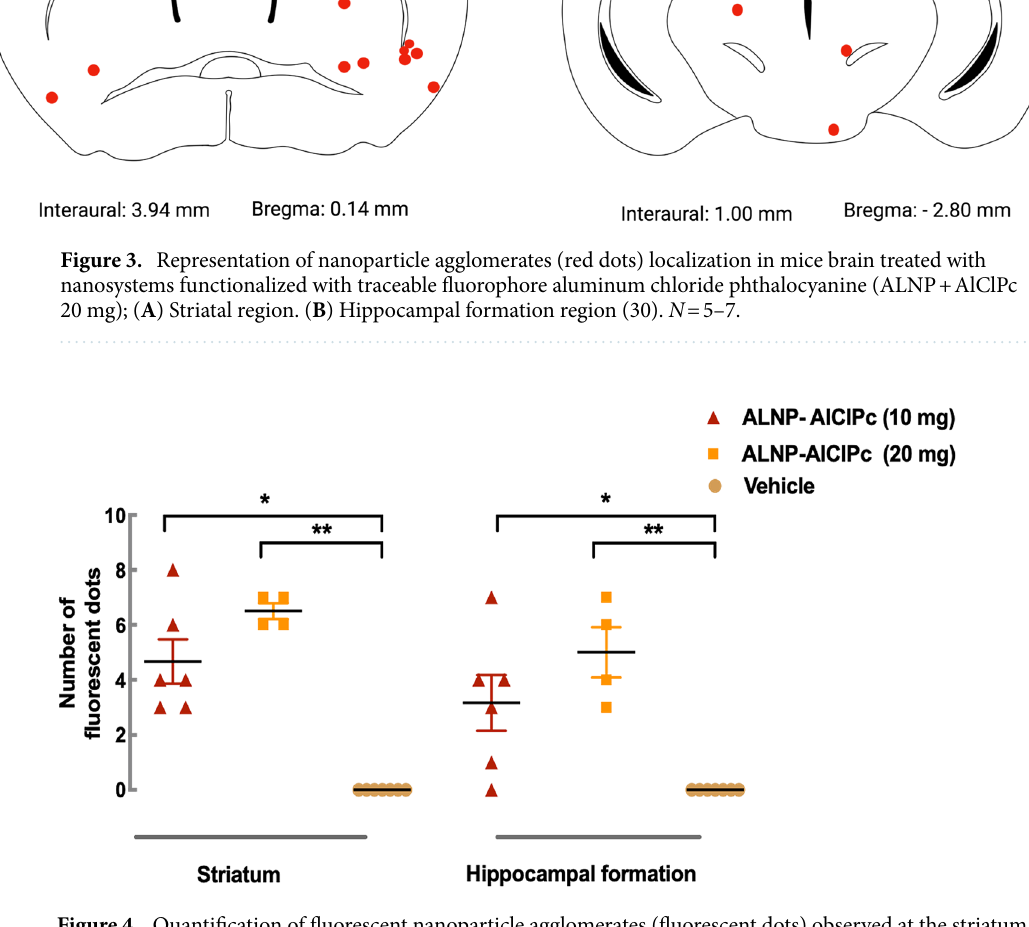
Figure 4. Quantification of fluorescent nanoparticle agglomerates (fluorescent dots) observed at the striatum or hippocampal formation according to treatment groups (saline vehicle or albumin/PLGA nanosystems functionalized with photoactive compound aluminum chloride phthalocyanine, ALNP + AlClPc, at concentrations of 10 or 20 mg/animal), 1 h post-injection. Data were submitted to Kruskal–Wallis test, followed by Dunn post-test. (*) p < 0.05 and (**) p < 0.001 when compared to vehicle group. N =